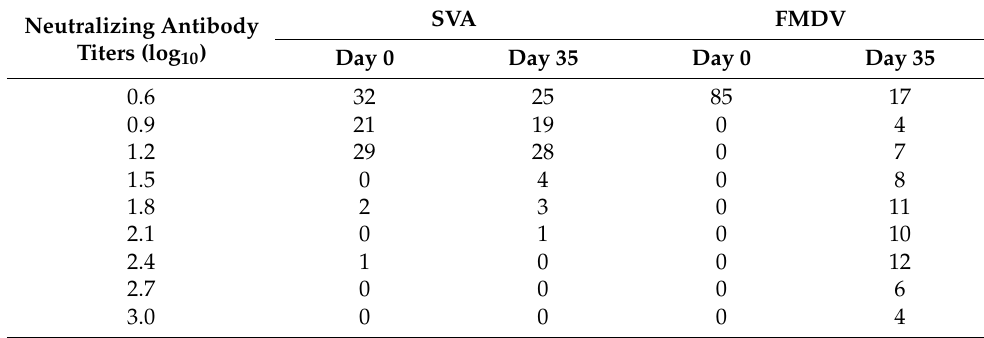
Table 3. SVA and FMDV neutralizing antibody titers in swine